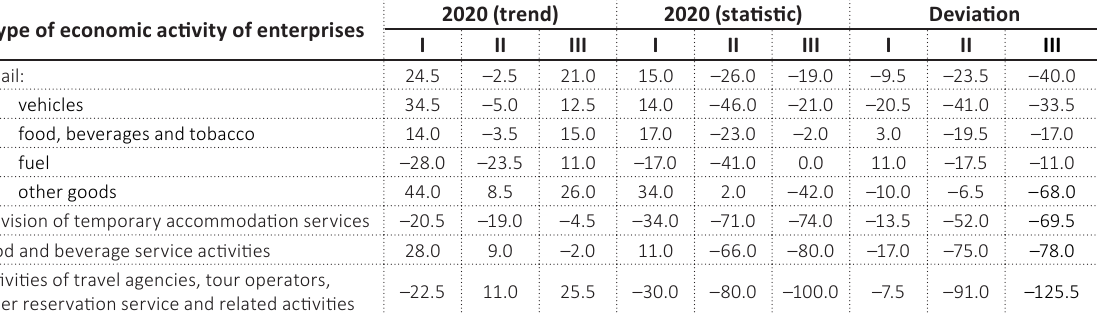
Table 3. Comparison of forecast (trend) and statistically significant values of expected changes in sales of goods (services) by enterprises of retail trade, hotel and restaurant and tourism business in 2020 Source: Compiled by the authors according to the State Statistics Service of Ukraine